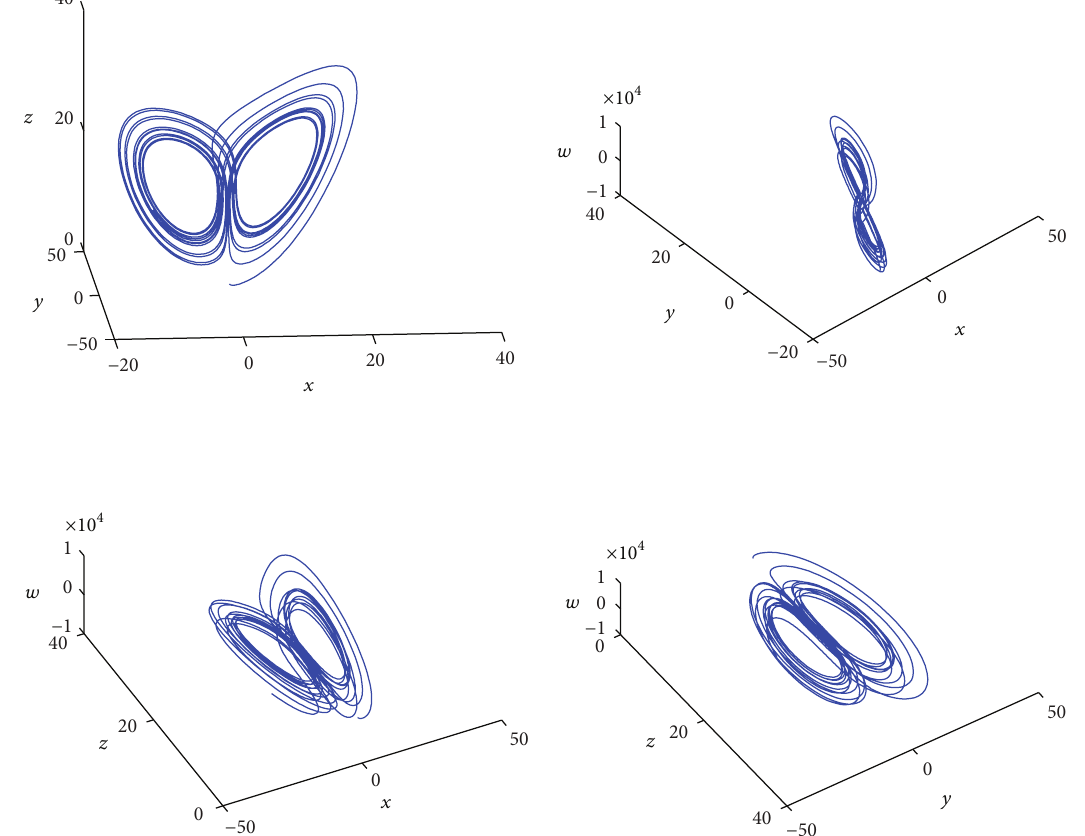
Figure 1: Response of the fractional-order hyperchaotic Chen system with respect to